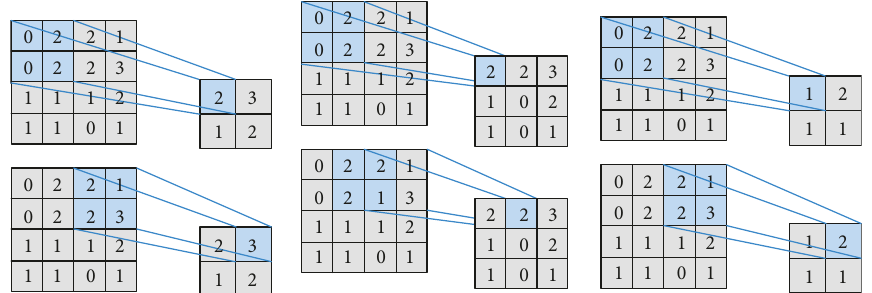
Figure 3: Pooling process (maximum pooling, random pooling, and mean